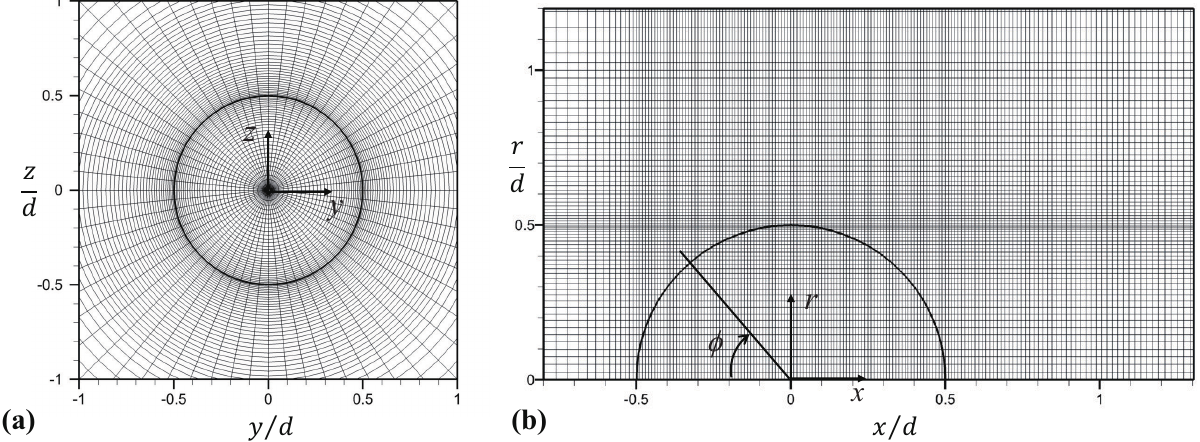
Figure 3. Grid distributions near the sphere: ( a ) in y – z plane; ( b ) in x – r plane. Every other grid is